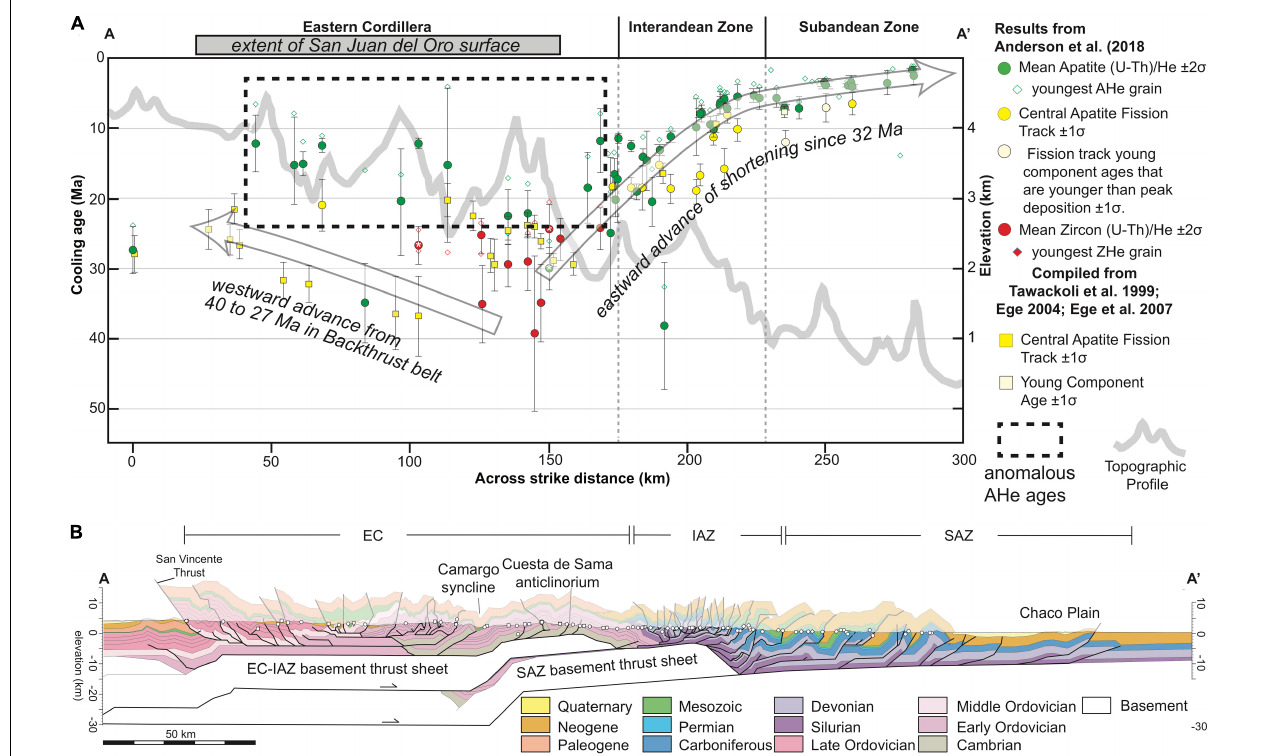
FIGURE 8 | (A) Synthesis of thermochronologic data from Anderson et al. (2018) emphasizing westward- and eastward-advancing contraction in the backthrust and forethrust portions of the Eastern Cordillera and Interandean/Subandean Zones, respectively. Dashed box highlights anomalous apatite (U-Th)/He results with varied ages and uncertainties. These data correspond to the region where the San Juan del Oro surface is developed, shown by the gray bar. (B) Balanced cross-section from Anderson et al. (2018) showing the location of tectonomorphic regions and thermochronology